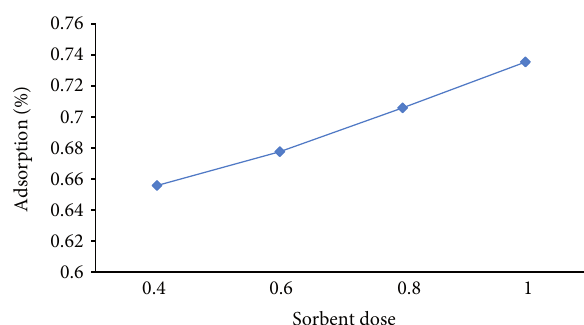
F 5: Effect of sorbent dose on the adsorption of real industrial waste water onto MVM.